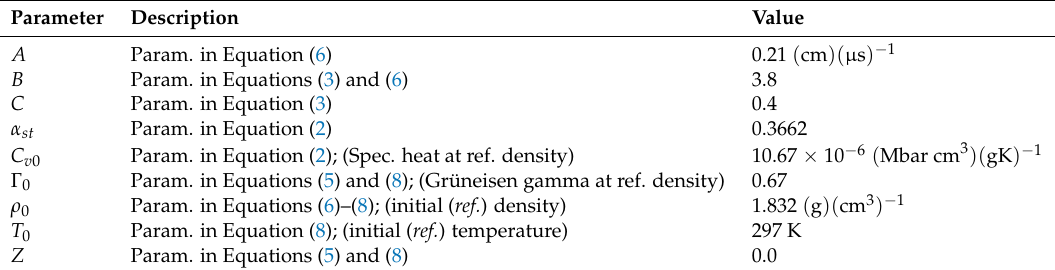
Table 2. Davis reactants parameter